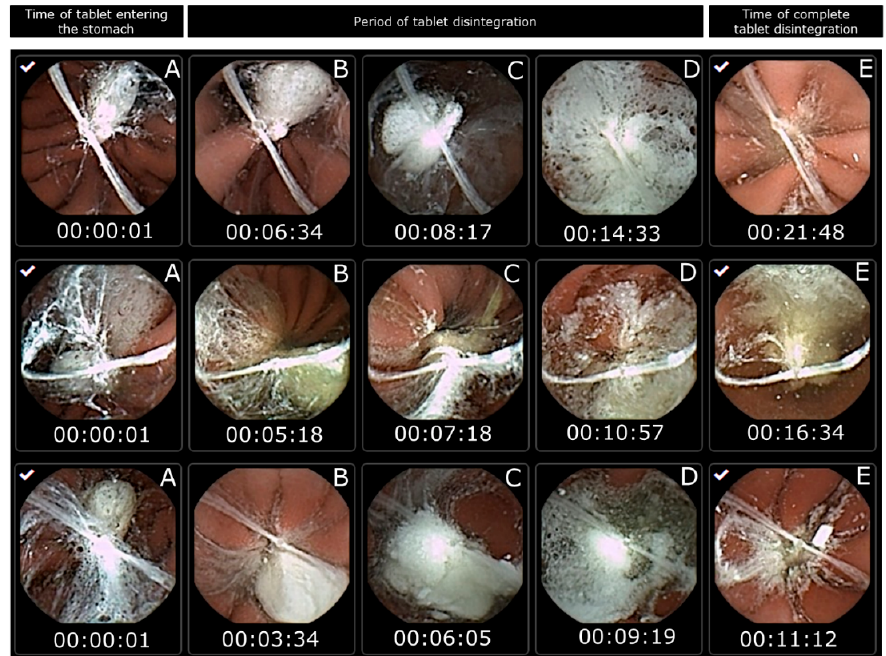
Figure 3. Images from capsule endoscopy to visualize Panadol Rapid disintegration time in each beagle dog after oral administration (n = 3). The time of the tablet entering the stomach is set as the start time ( A ). The period of tablet disintegration is while the tablet is still visible ( B , C , D ). The time of complete tablet disintegration is when no residue is seen of the tablet or the tablet is fully fragmented ( E ).